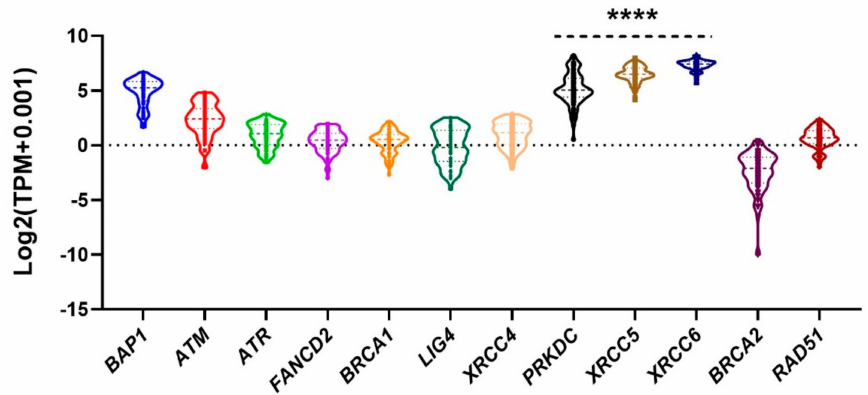
Figure 2. Confirmatory expression of NHEJ pathway genes in the Cancer Genome Atlas (TCGA). TCGA UM ( n = 79) mRNA expression of genes involved in DNA repair pathways ( n = 10). When compared to DSB-HR pathway genes ATM, ATR, FANCD2, BRCA1, BRCA2 and RAD51 , NHEJ pathway genes PRKDC (Alias DNA-PKcs ), XRCC5 and XRCC6 were significantly highly expressed in UM (Tukey’s multiple comparisons test ****Adjusted P value < 0.0001). BAP1 expression is normalized across both D3 and M3 UM, which accounts for the comparative